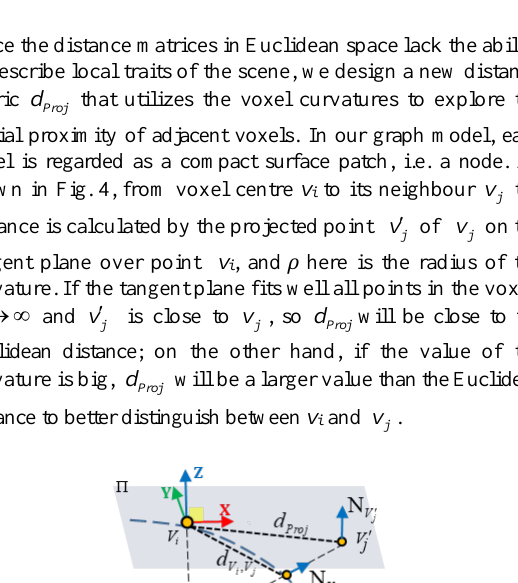
Figure 3. The geodesic distance between P 1 and P 2 , who are close to each other but have obvious spatial difference.